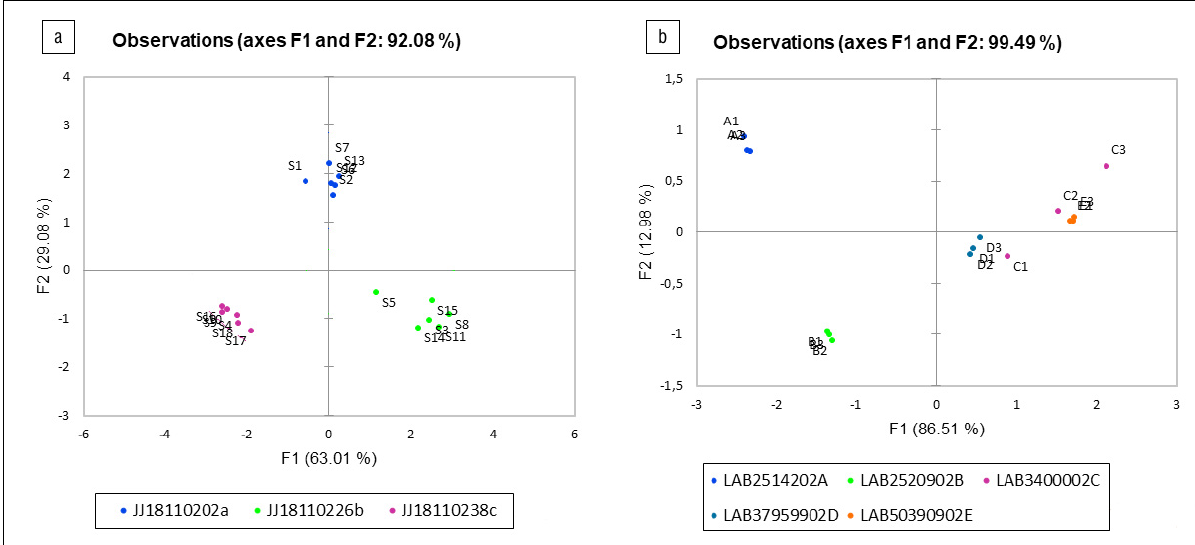
Figure 4: Observation axis for (a) blind simulated nyaope and (b) casework samples analysed using principal component